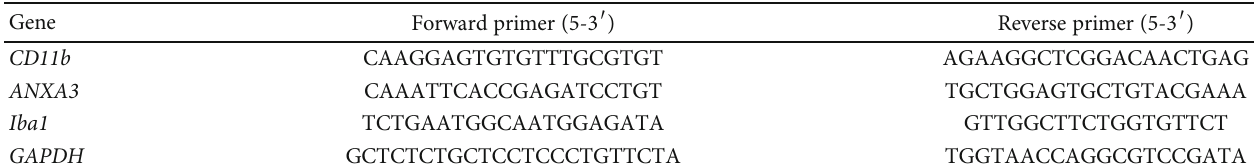
Table 1: Sequence of primers used for real-time PCR.